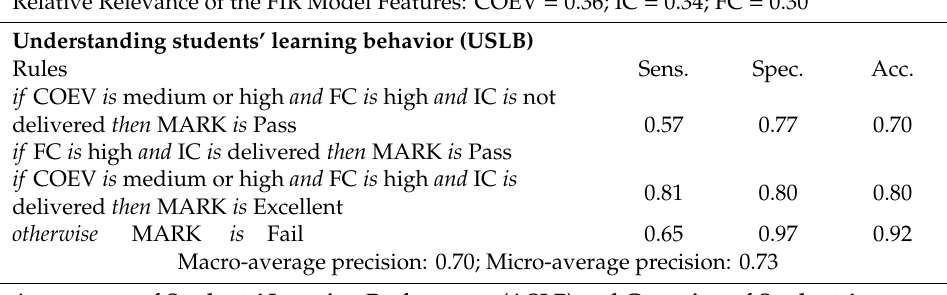
Table 4. ACEP, USLB, ASLP, and GSLB toolbox results for the model 3 of the didactic planning course. The MARK variable was discretized into three classes: fail (from 0–6), pass (from 6.9–8.9), and excellent (from 9–10). FC and COEV were discretized into three classes: low (from 0–5), medium (from 5.1–7.9), and high (from 8–10). IC variable was discretize, also, into two classes: delivered and not delivered. Spec., Sen., and Acc. stand for specificity, sensitivity, and accuracy,